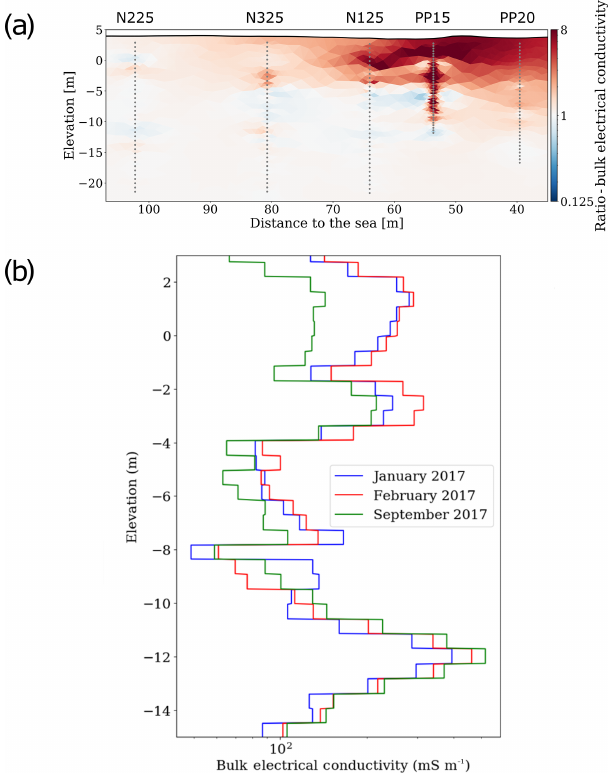
Figure 9. (a) Ratio of October 2016 to February 2017 CHERT ECs. (b) Extraction of CHERT bulk EC profiles along PP20. The winter period with higher significant wave heights is marked by a twofold increase in bulk electrical conductivity values from the coastline un- til 90m from the coastline. The extractions in (b) show the bulk EC in the upper layers during winter (200mSm − 1 ), and the recovery 6 months after winter (100mSm − 1 ). The extractions also evidence the increase in conductivity in the lower